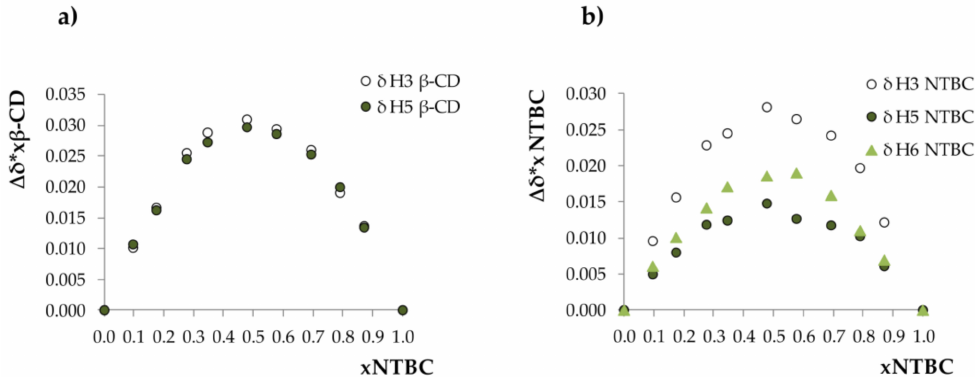
Figure 1. Job’s plots for β -CD/NTBC constructed according to the chemical shifts of ( a ) protons H 3 and H 5 of β -CD, and ( b ) the aromatic protons of